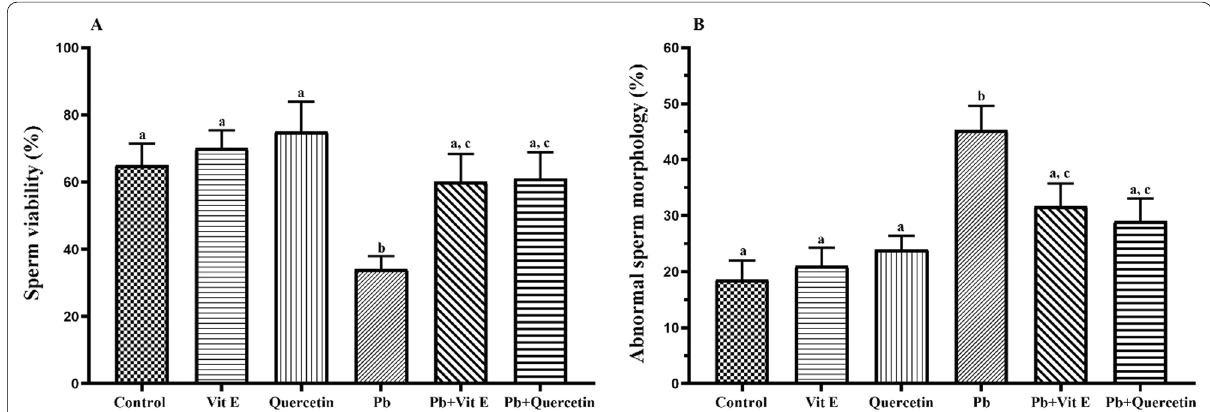
Fig. 5 Effect of Vitamin E and quercetin on sperm viability and abnormal sperm morphology in lead acetate treated male Wistar rats. Bars represent mean SEM, means bearing different superscripts between groups differ significantly at p < ±